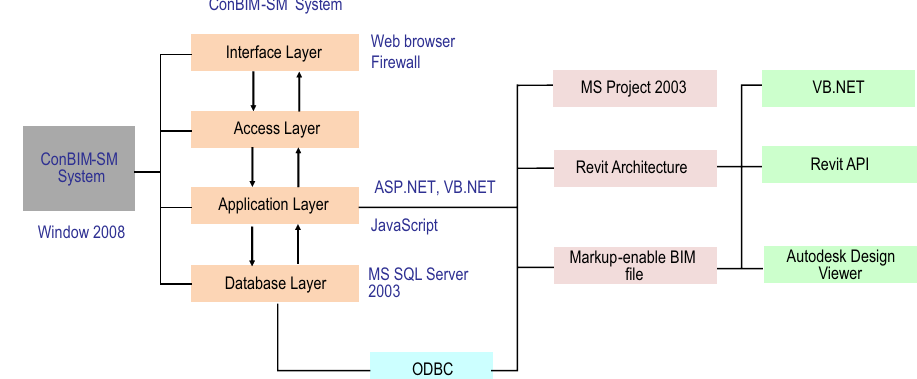
Fig. 3. ConBIM-SM system architecture